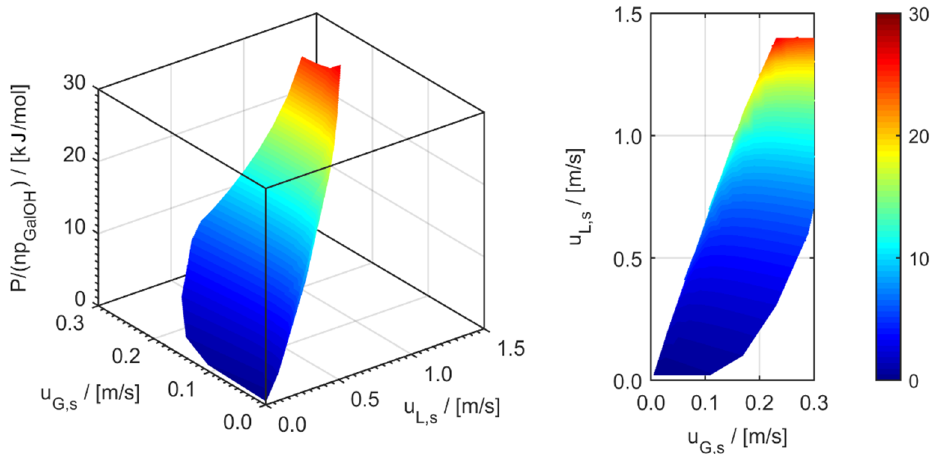
Figure 12. Specific energy consumption of particle-packed minichannel reactors operating at different gas and liquid superficial velocities.